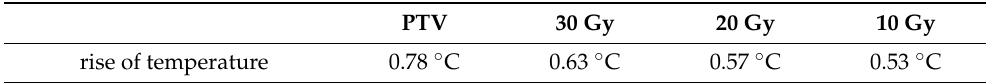
Table 2. Temperature increase in selected areas (PTV 30 Gy, 20 Gy and 10 Gy) in the third week of treatment.